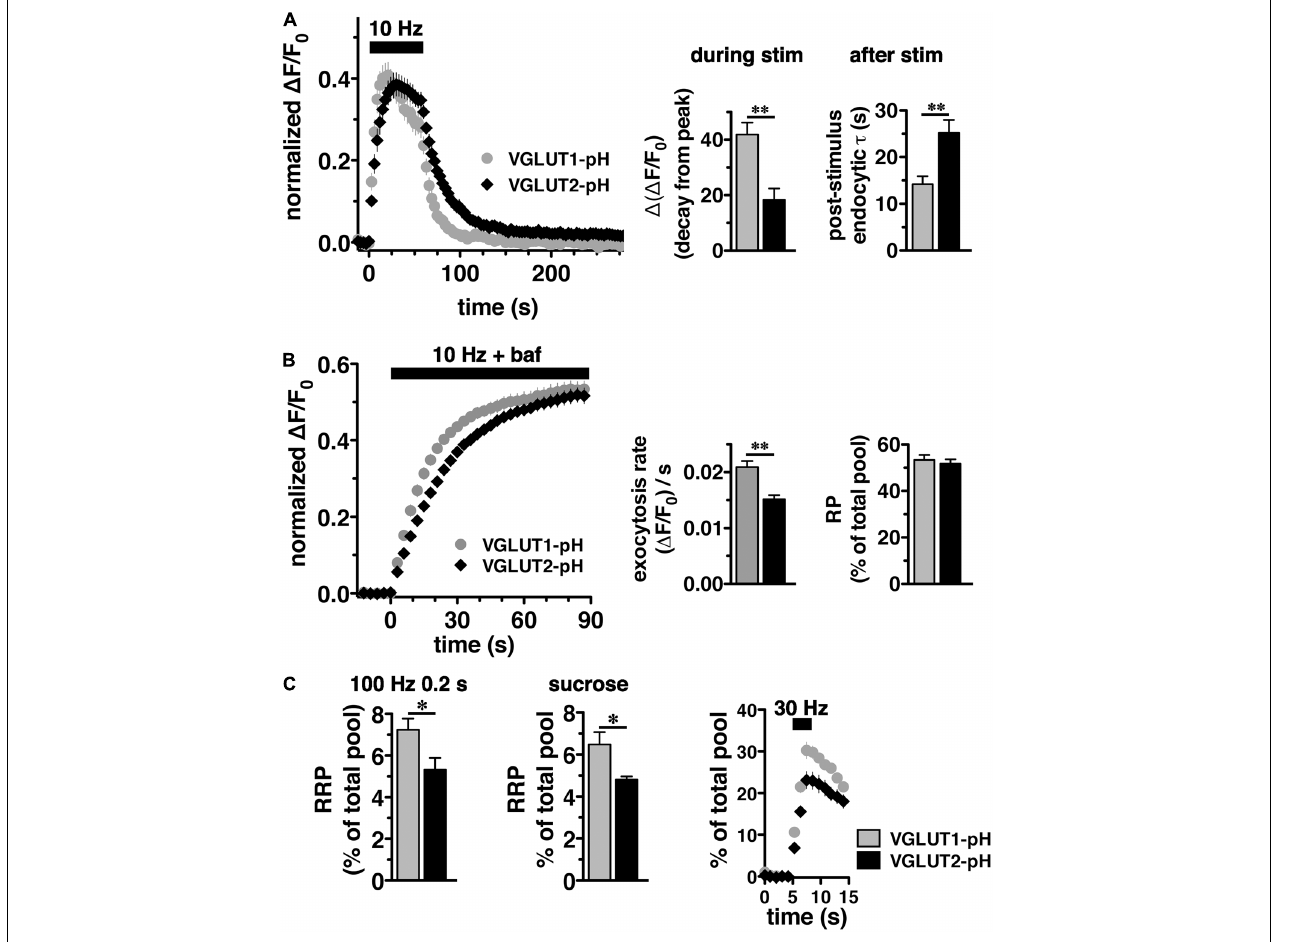
FIGURE 2 | Vesicular glutamate transporter 2-pH recycling differs from VGLUT1-pH. (A) Left panel: The time course of exo- and endocytosis in response to electrical stimulation at 10 Hz 60 s (bar) is monitored by the increase and decrease in the fluorescence of VGLUT2-pH (black) or VGLUT1-pH (gray) at hippocampal synaptic boutons, acquired every 3 s. Each trace was normalized to the size of the total pool of VGLUT-pH as determined by application of 50 mM NH 4 Cl. The fluorescence of both VGLUT1-pH and VGLUT2-pH increases rapidly upon stimulation and decays with an exponential time course after cessation of the stimulus, consistent with exocytosis followed by endocytosis (left panel). Middle panel: The extent of fluorescence decay from peak [ (cid:49) ( (cid:49) F/F 0 )] during stimulation is less for VGLUT2-pH (black, 18.26 ± 4.13% from peak, n = 9) than VGLUT1-pH (gray, 41.90 ± 4.31% from peak, n = 11, ∗∗ p < 0.01). Right panel: The post-stimulus endocytic rate of VGLUT2-pH (black, τ decay = 25.20 ± 2.77 s) is also significantly slower than that of VGLUT1-pH (gray, τ = 14.18 ± 1.73 s, ∗∗ p < 0.01). (B) Left panel: To measure exocytosis, hippocampal neurons expressing VGLUT2-pH or VGLUT1-pH were stimulated at 10 Hz for 90 s (bar) in the presence of 0.5 µ M bafilomycin (baf). Middle panel: VGLUT2-pH exhibits a slower initial rate of exocytosis than VGLUT1-pH, calculated as the linear rate of fluorescence change, acquired every 3 s, from 0 to 15 s (VGLUT2-pH, 0.0151 ± 0.0008, n = 9; VGLUT1-pH, 0.0209 ± 0.0011, n = 10, ∗∗ p < 0.01). Right panel: Both VGLUT1-pH and VGLUT2-pH fluorescence plateau at a similar level in response to 900 action potentials, indicating that there is no significant difference in the total amount of VGLUT-pH released from the recycling pool (RP, VGLUT1-pH, 53.38 ± 2.11%; VGLUT2-pH, 51.73 ± 1.92% of total pool). (C) Left panel: The fraction of VGLUT2-pH in the readily releasable pool (RRP) is less than VGLUT1-pH, when exocytosis from the RRP is evoked using a stimulus of 20 action potentials at 100 Hz (VGLUT2-pH, 5.32 ± 0.57%, n = 10; VGLUT1-pH, 7.24 ± 0.53%, n = 11, ∗ p < 0.05), or middle panel : by application of hypertonic (300 mM) sucrose in Tyrode’s solution (VGLUT2-pH, 4.81 ± 0.15%, n = 6; VGLUT1-pH, 6.48 ± 0.58%, n = 5, ∗ p < 0.05). Right panel: Similar results are obtained with an alternate stimulus of 30 Hz for 3 s to release RRP. The release of VGLUT2-pH (black, 6.81 ± 0.640% of total pool, n = 8) even from the first second of stimulation (30 action potentials)